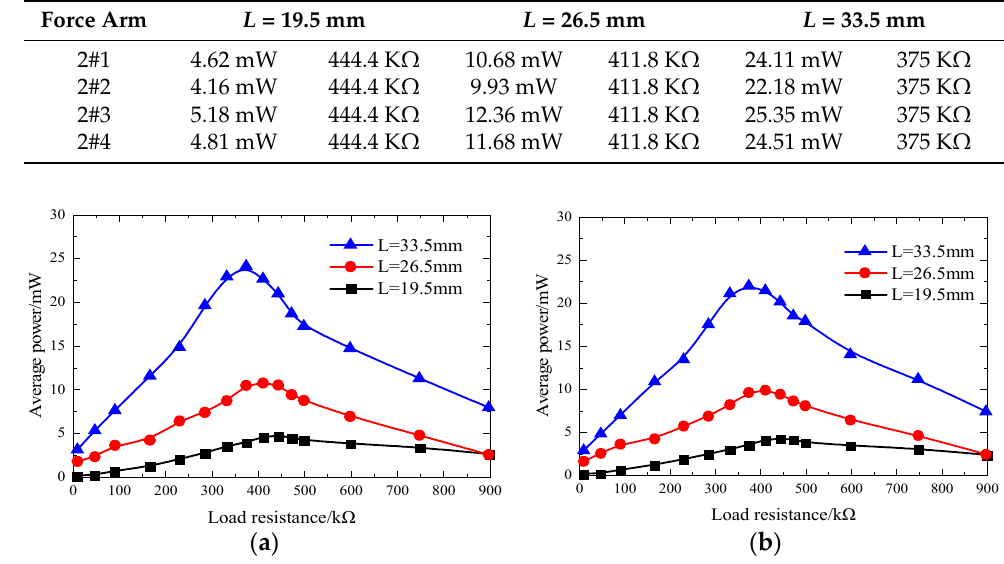
Figure 14. Average powers from bimorph PCS1 of 2# piezoelectric brick versus the load resistance and force arm length ( F = 500 N, f = 1 Hz). ( a ) 2#1 PZT4 patch; ( b ) 2#2 PZT4 patch.